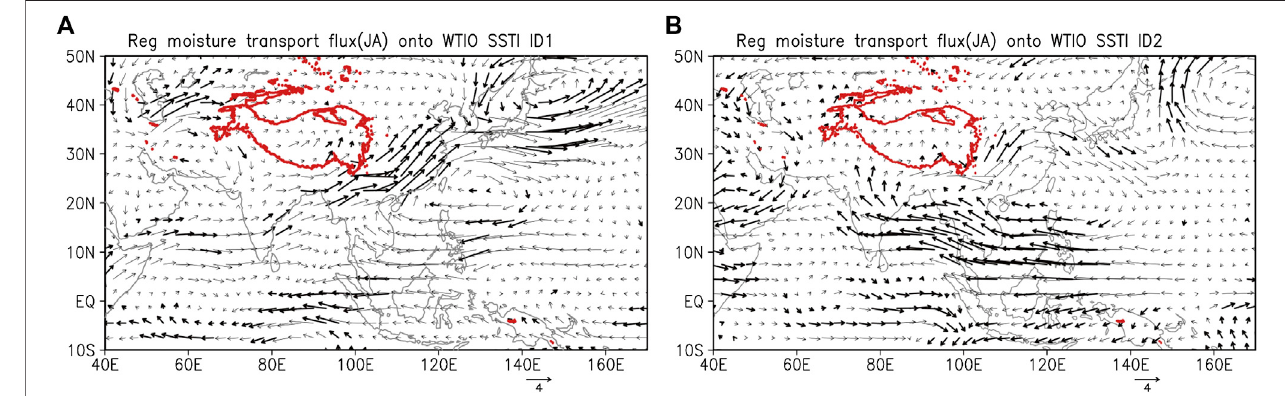
FIGURE5| Regressed fi eldsofmoisturetransport fl uxat600hPa(vectors,10 -3 kg · m − 1 · s − 1 )against WTIOSSTIfor (A) ID1and (B) ID2.Thickvectorsindicateareas that signi fi cant at 90% con fi dence